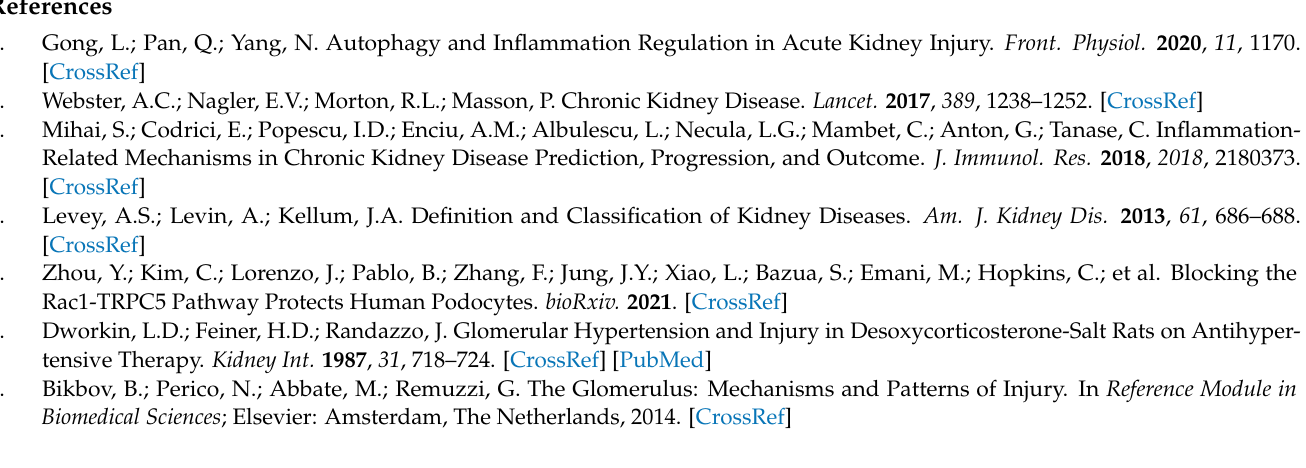
primers, Table S5: Top ten GO biological pathways expressed in PAN-treated kidney organoids, Table S6: Top ten downregulated biological pathways and processes of KEGG analysis, Table S7: Top ten upregulated biological pathways and processes of KEGG analysis, Figure S1: Effects of PAN on kidney organoids detected by H&E staining, immunofluorescence staining and Western blotting, Figure S2:Confirmation of transcriptome data and details of the cytokine array data.